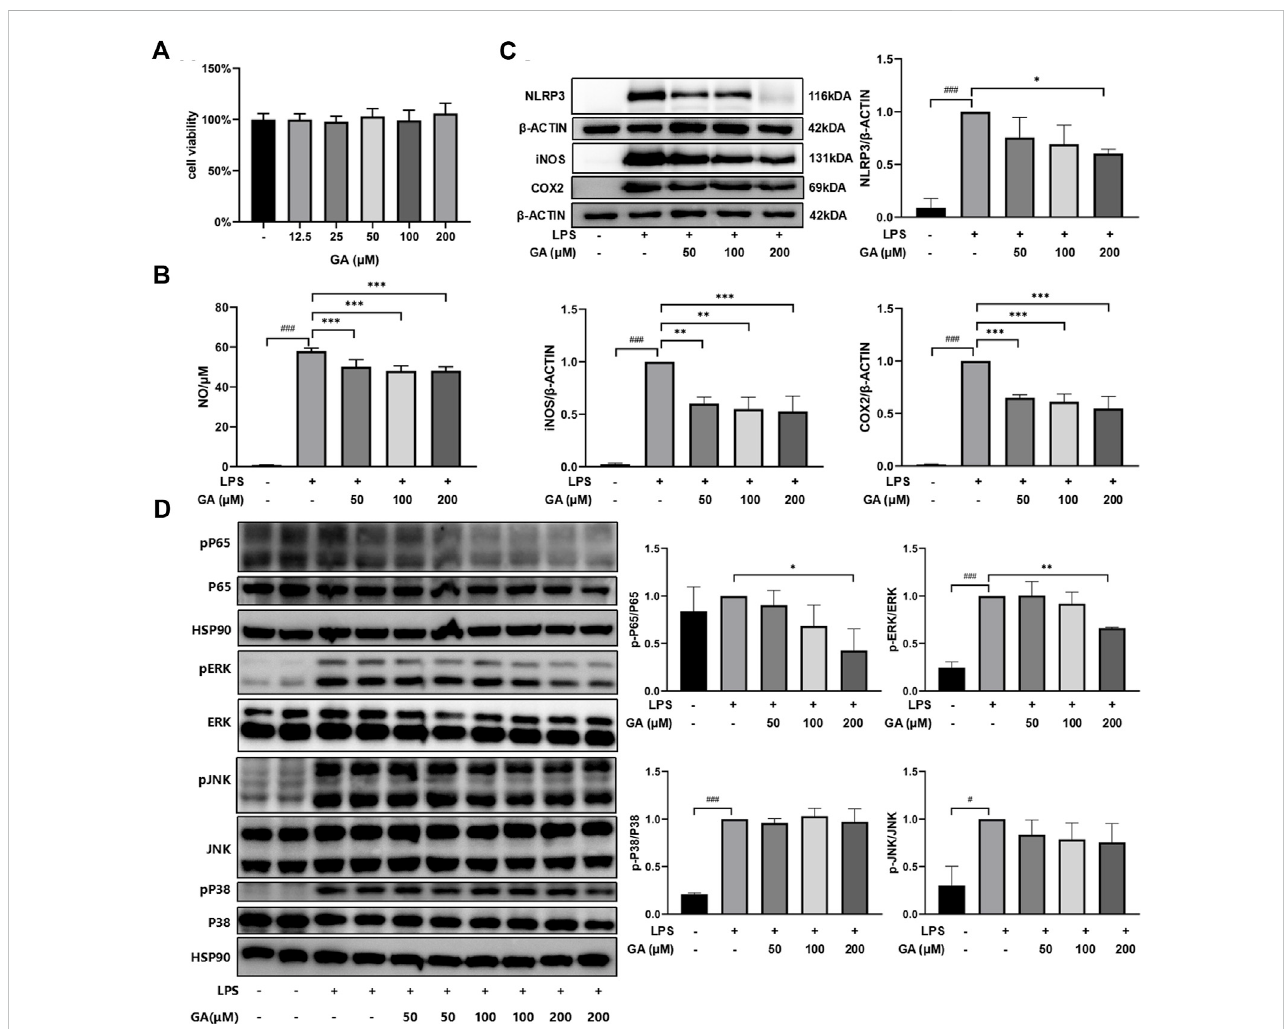
FIGURE 5 GA suppressed in fl ammatory response in LPS-stimulated RAW264.7 macrophages. Cells were co-treated with GA at 50, 100, and 200 μ M in the presence of LPS (1 μ g/mL) for 24 h. (A) Cell viability was measured by using CCK-8 assay. (B) NO production was determined by Griess reagents. (C) The protein expressions of NLRP3, iNOS, and COX2 in LPS-stimulatedRAW264.7 cellsweremeasured using western blotting. (D) The protein expressions of p65- NF- κ B, ERK, JNK, and P38 in the LPS-stimulated RAW264.7 cell were measured in western blotting. Data are presented as mean ± SD (n = 3). ### p